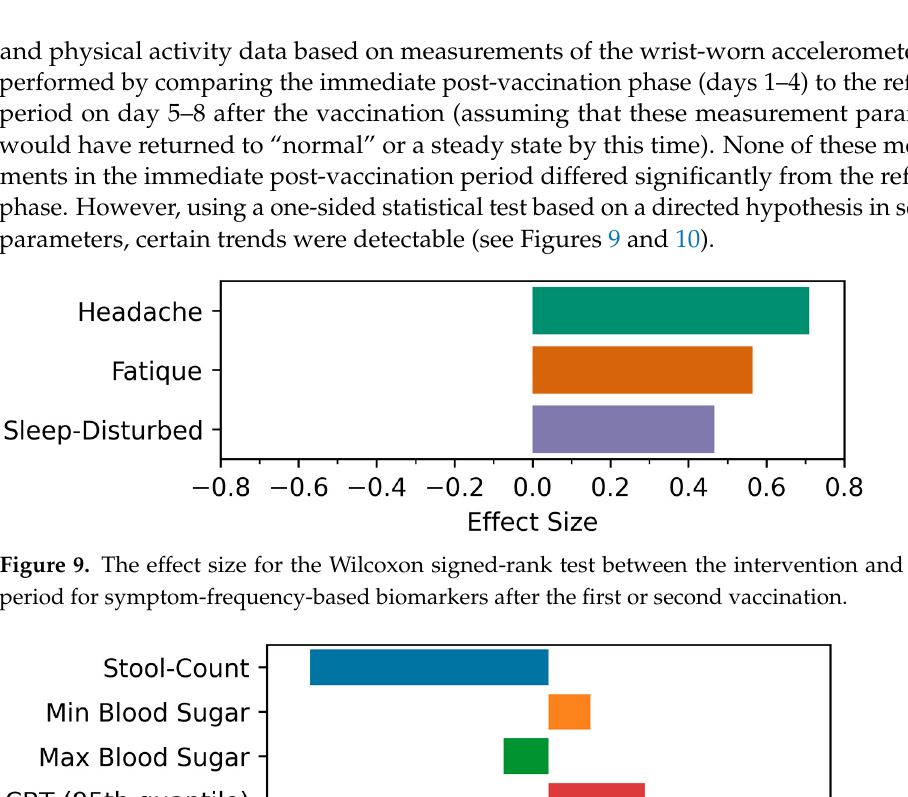
Figure 10. The effect size for the Wilcoxon signed ‐ rank test between the intervention and control period for symptom-intensity-based biomarkers after the first or second vaccination. CBT: Core Body period for symptom ‐ intensity ‐ based biomarkers after the first or second vaccination. CBT: Core Temperature Body Temperature Sensor.